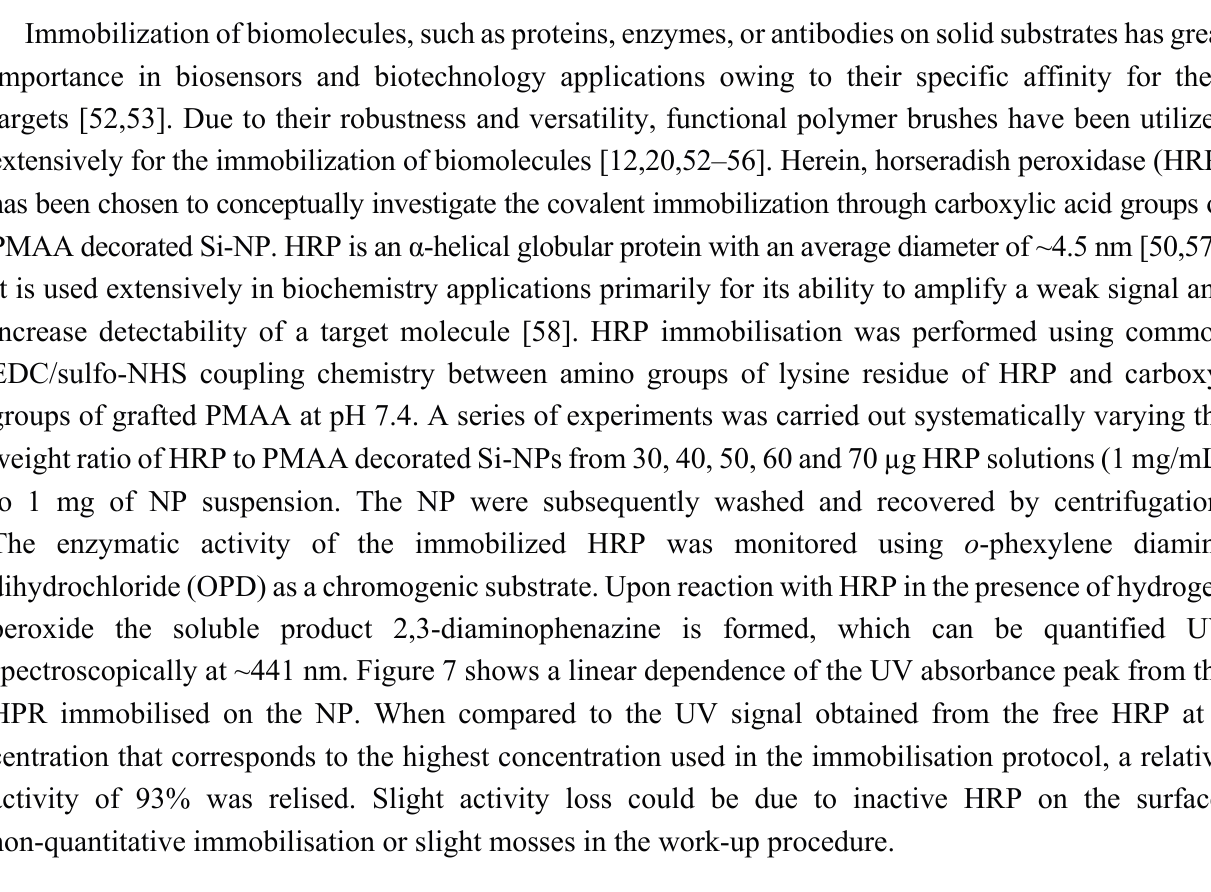
Figure 6. FE-SEM images of Si-NP of different size and state of decoration. ( A ) and ( B ): bare Si-NP; ( C ): ATRP initiator decorated NP; ( D ): PBMA brush decorated Si-NP; ( E ) and ( F ): PMAA brush decorated